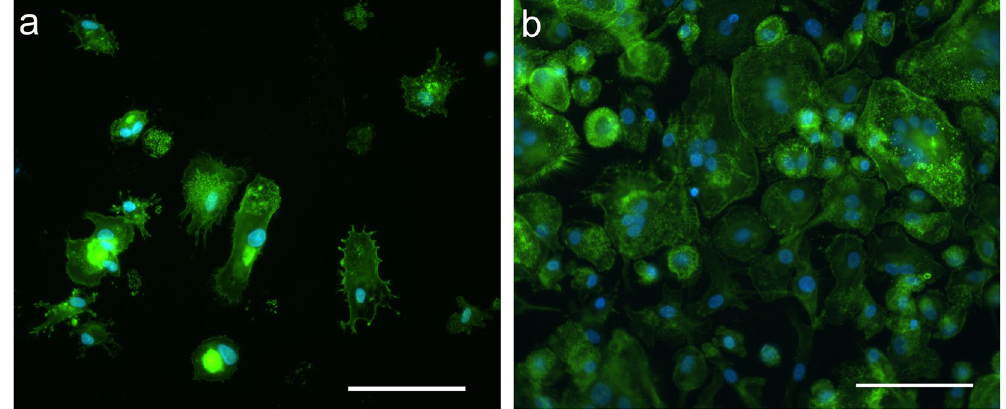
Figure 1. Epifluorescence microscopy. M1 ( a ) and M2 ( b ) MDMs labelled with FITC-phalloidin to stain cytoskeletal actin (in green), and DAPI nuclear counterstain (in blue). Scale bar: 100 μ m.